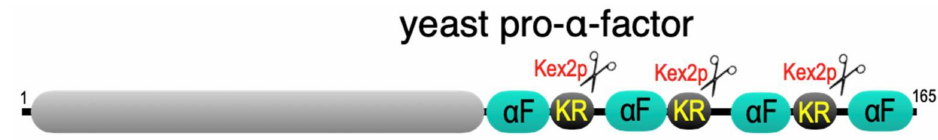
Figure 3. Yeast pro- α -mating factor. Shown are the four cryptic α -factor ( α F) peptides and the flanking -LysArg- cleavage sites, which are processed by